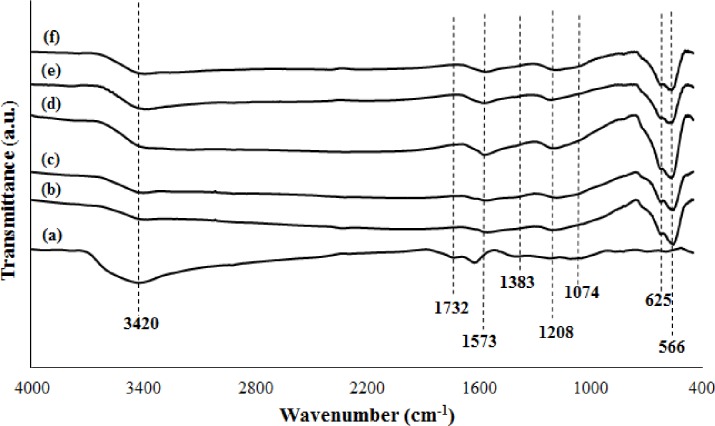
FTIR spectra of (a) GO, (b) M-rGO3, (c) M-rGO6, (d) M-rGO12, (e) M-rGO18 and (f) M-rGO24.